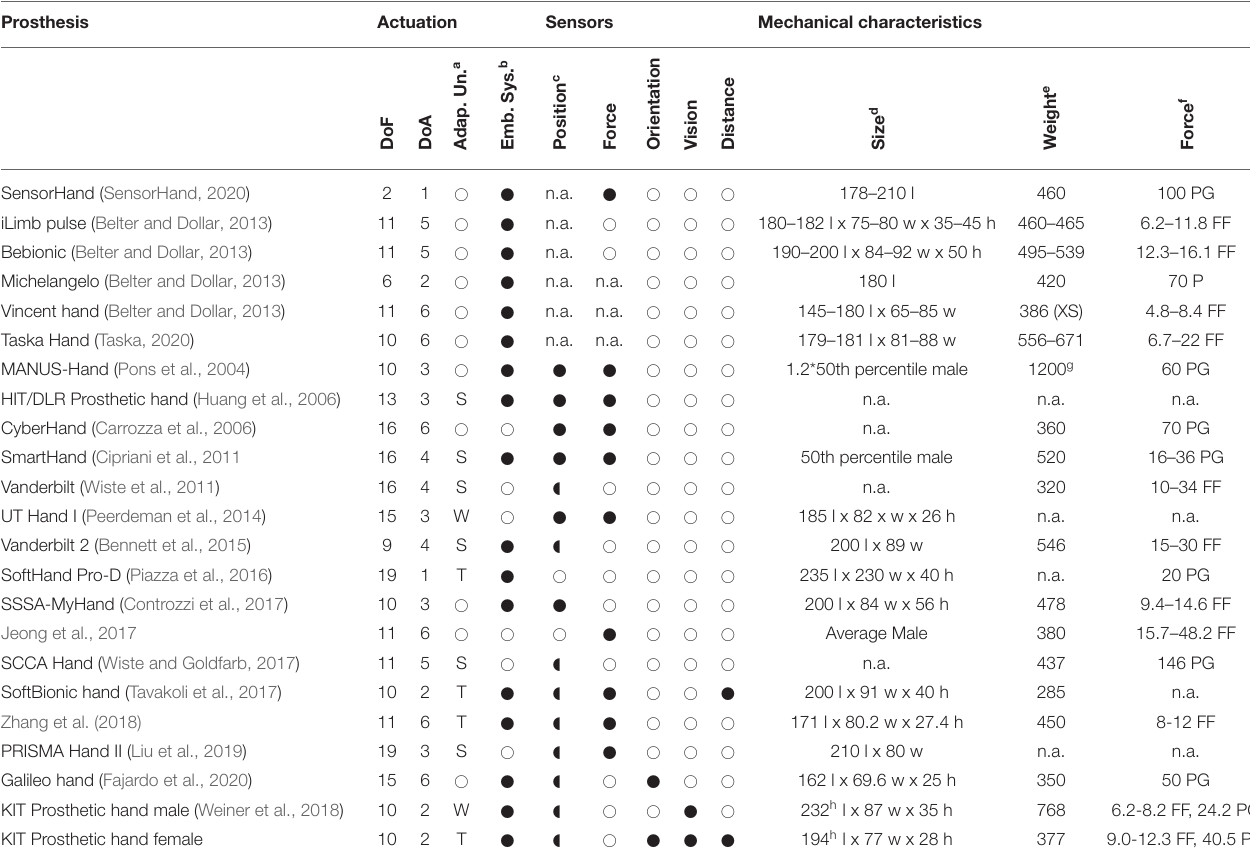
TABLE 1 | Overview of commercial and research